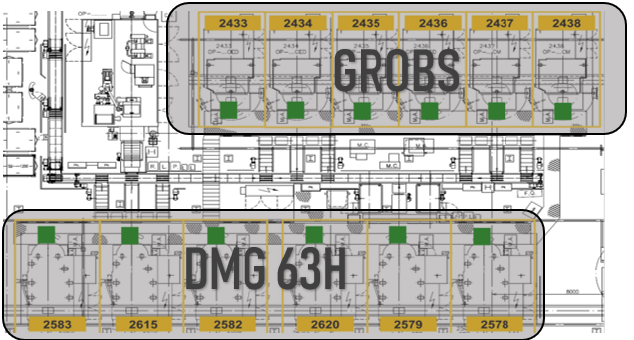
Figure 5. Module 1—Manufacturing machines.